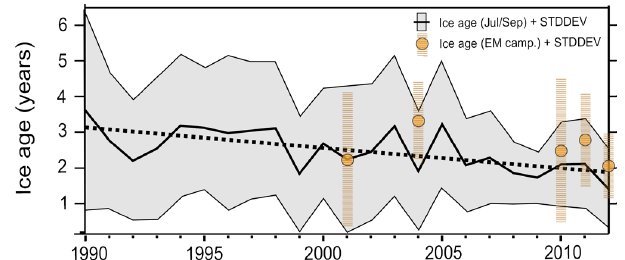
Figure 3. Comparison of age of sea ice covered by EM measure- ments and mean summer ice age in Fram Strait obtained from Maslanik et al. (2011): the black line represents the average July– September ice age along the meridional and zonal gates through which satellite-derived ice area fluxes were calculated (compare red line in Fig. 1). A trend line is added (dashed black line). The age of sea ice covered by EM measurements between 2001 and 2012 is indicated by orange circles. The gray shaded area and dashed bars correspond to the standard deviation of ice age for satellite and ob- servational data,